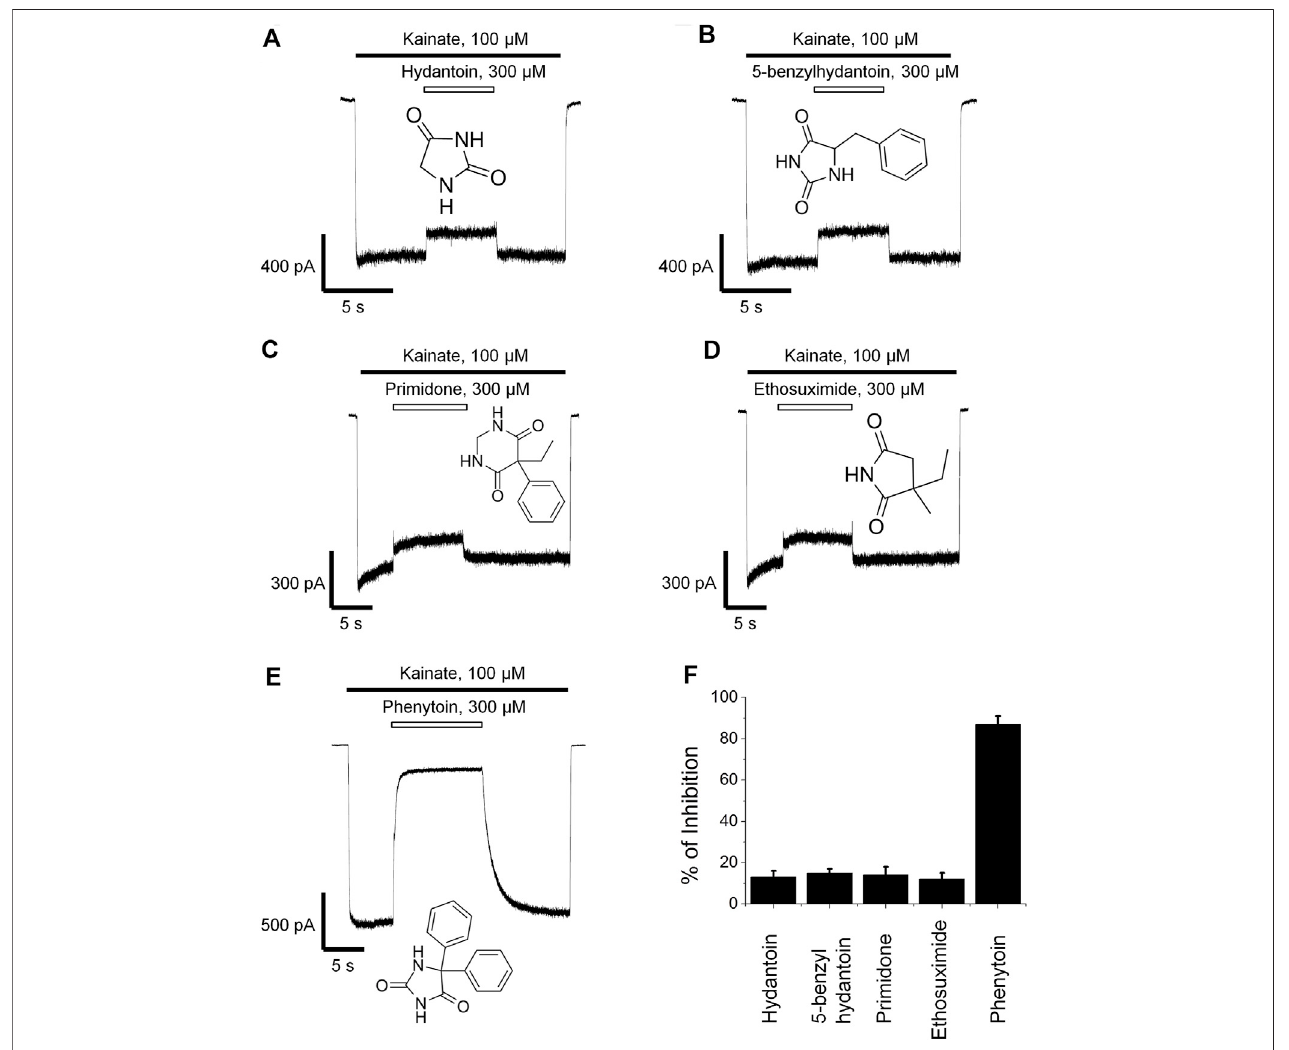
FIGURE 2 | Action of compounds structurally related to phenytoin on CI-AMPARs. Representative examples of weak inhibition by 300 µM hydantoin (A) , 5- benzylhydantoin (B) , primidone (C) , and ethosuximide (D) and strong inhibition by 300 µM phenytoin (E) . (F) Summarized results of AMPARs inhibition by these compounds at 300-µM